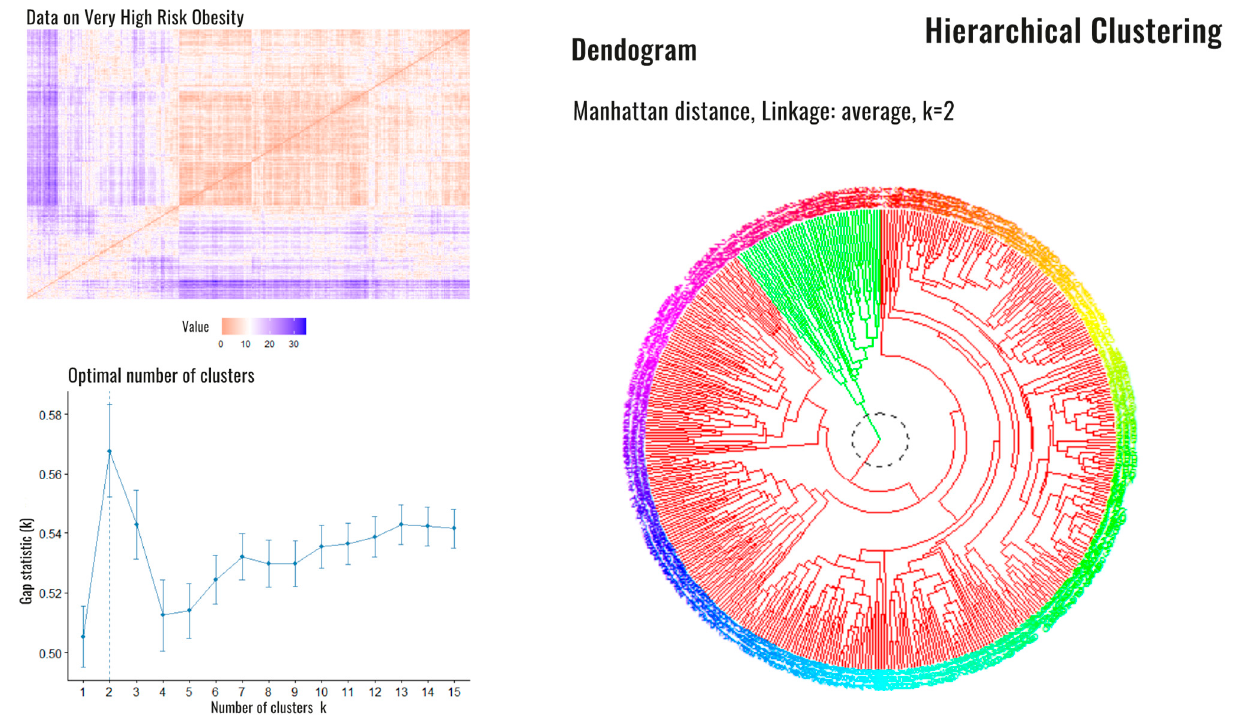
Figure 3. Dissimilarity matrix, optimal number of clusters and dendrogram corresponding to high- risk patients. Legend: Dissimilarity matrix ( upper left ), the optimal number of estimated Clusters ( down left ). On the right side, the dendrogram is shown with the presence of the two clusters: cluster 1 (red) and cluster 2 (green).